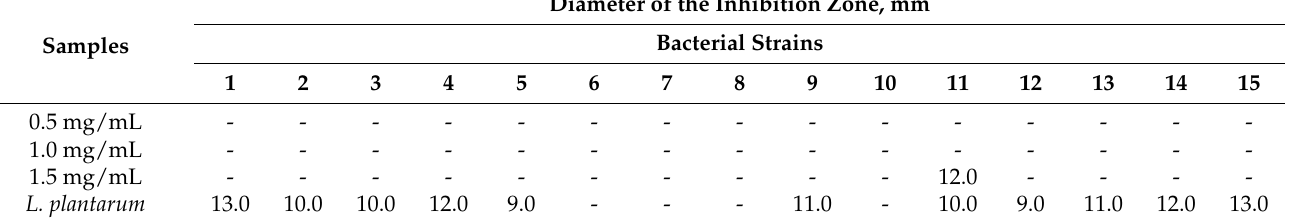
Table 2. Diameters of inhibition zones (mm) of the pine needle extract and L. plantarum strain against bacterial